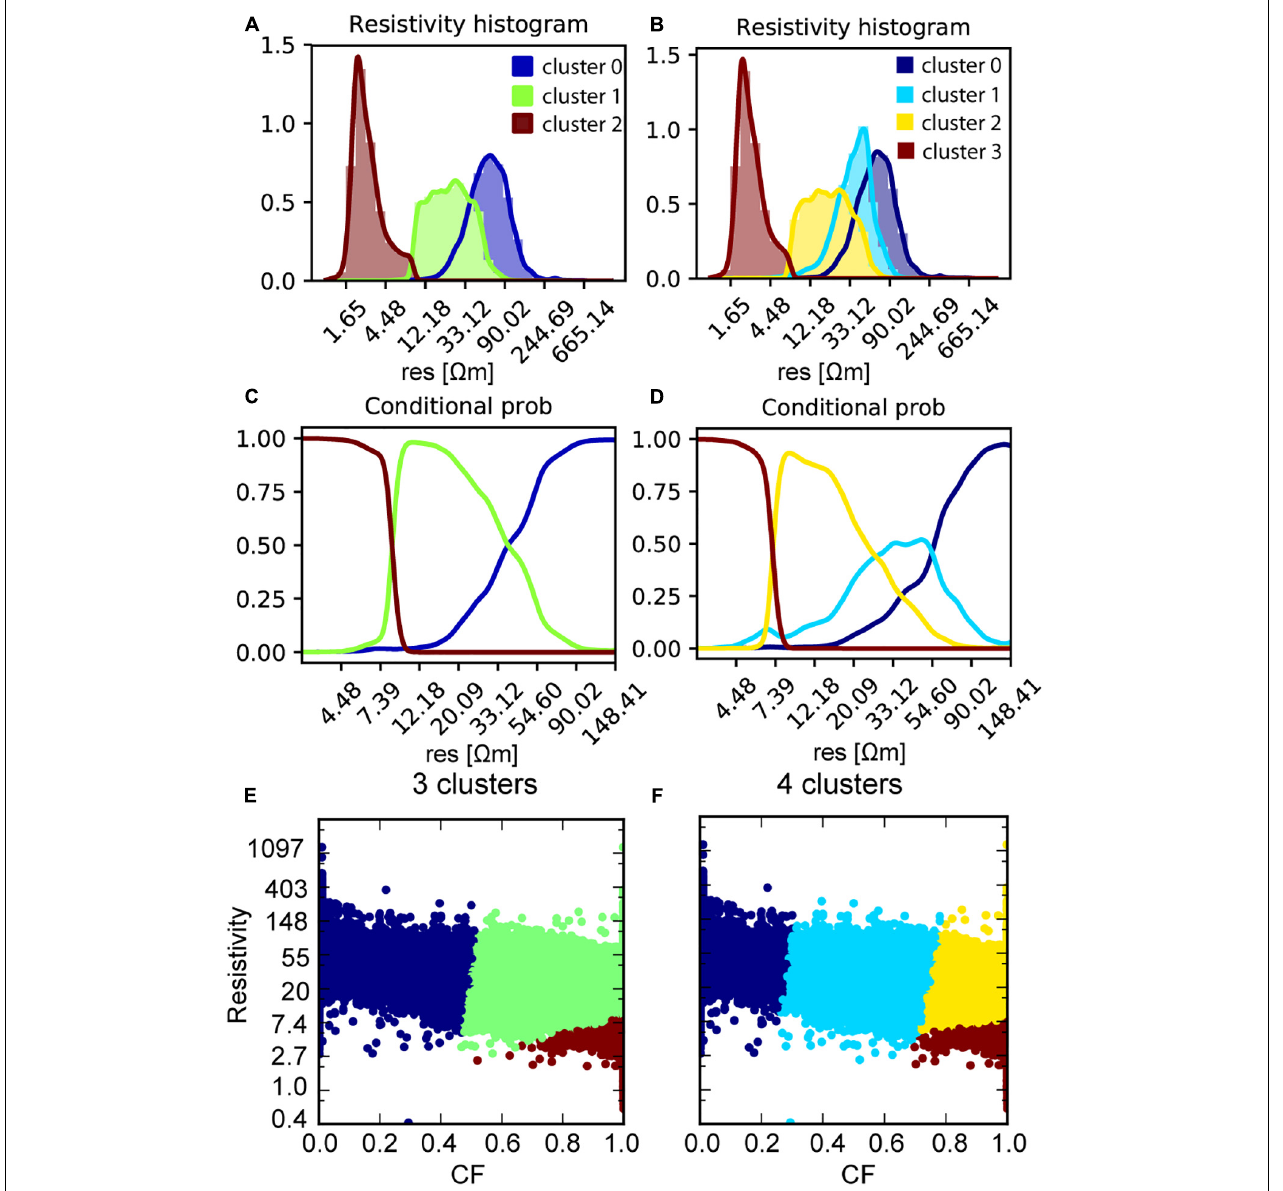
FIGURE 3 | Results of the cluster analysis on CF and resistivities. (A) shows the result of the 3-cluster analysis plotted as histograms in the resistivities. (B) shows the histograms for the 4-cluster analysis on resistivities. (C) shows the conditional probabilities of the 3-cluster analysis. (D) shows the conditional probabilities of the 4-cluster analysis. (E) show clustering of the cloud spanned by resistivities and CF into 3 clusters. Finally, (F) shows the clustering of the cloud spanned by resistivities and CF subdivided by 4